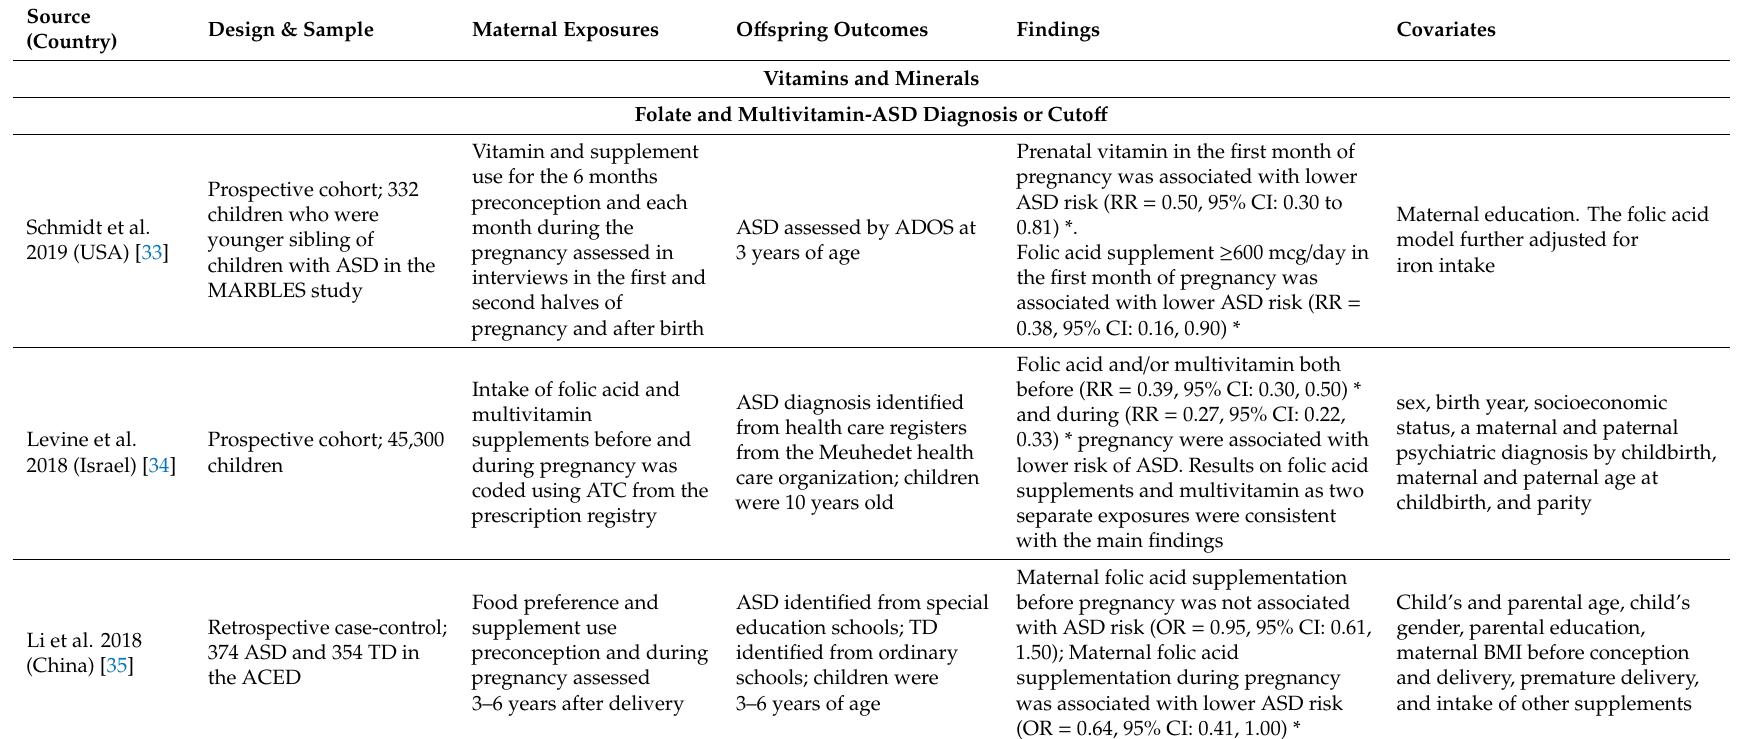
Table 1. Studies on maternal nutrition and o ff spring ASD risk or